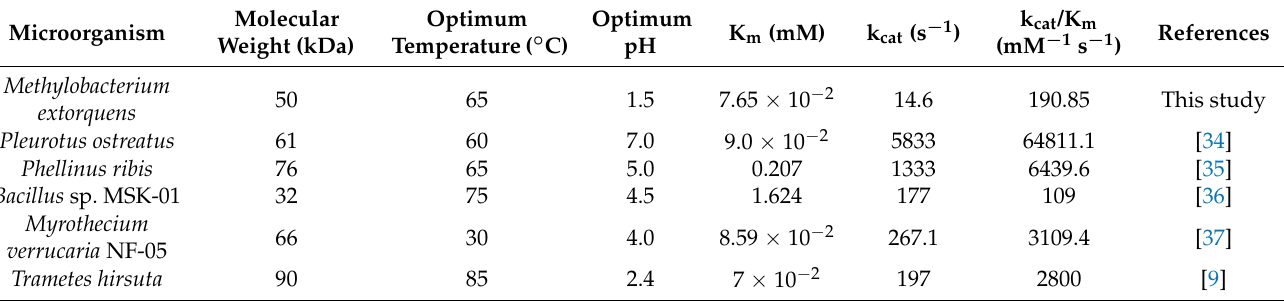
Table 2. Comparison of enzymatic parameters of different non-blue